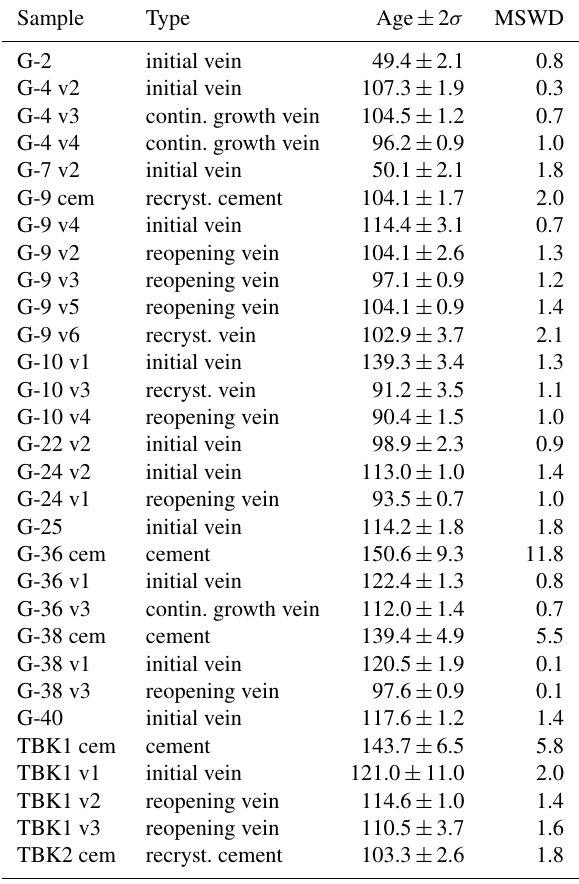
Table 1. U–Pb calcite formation ages of calcite cements and veins of the Lindemans Bugt Formation. MSWD is the mean squared weighted